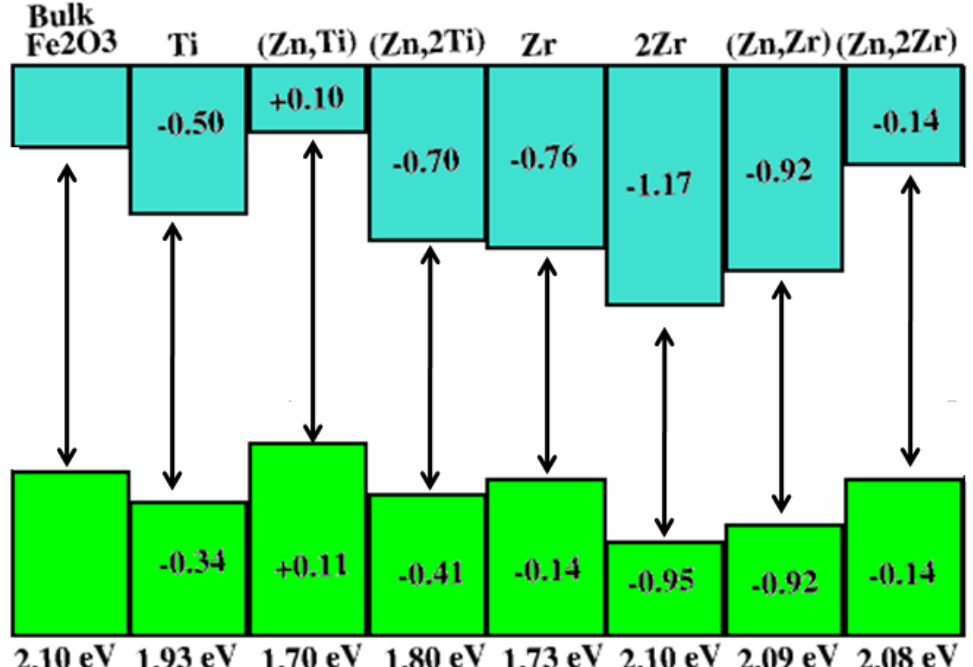
Figure 7. VBM and CBM positions of doped systems as calculated with respect to that of bulk α-Fe 2 O 3 . The plus (+) and minus (−) signs denote up or downshifting of the bands with reference to VBM and CBM of bulk α-Fe 2 O 3 , respectively.